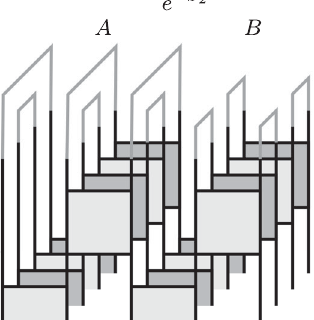
FIG. 25. Boundary conditions defining the entanglement membrane that appears in the calculation of the purity e − S 2 ð t Þ of subregion A . Subregion A is on the left, where copies of the evolution operator are contracted as in the “ − ” pairing of Eq. (58). The subregion B on the right corresponds to the “ þ ”